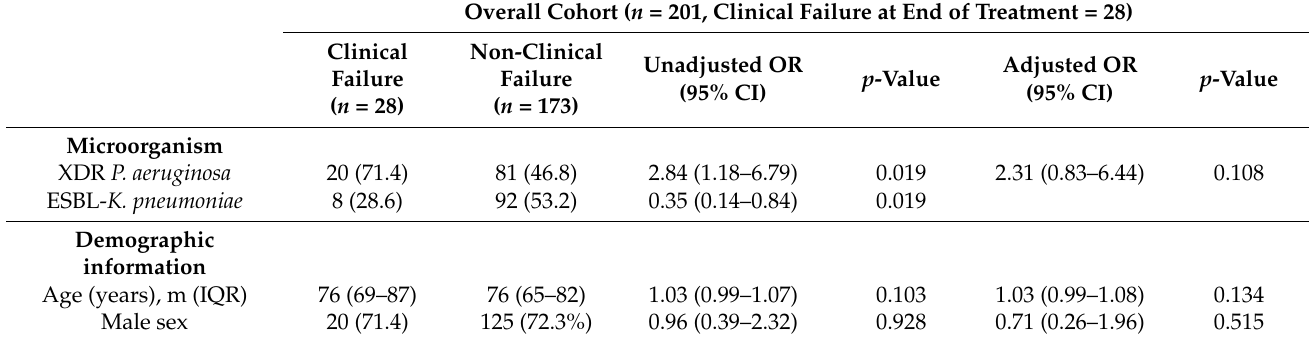
Table 3. Univariate and multivariate analysis of parameters predicting clinical failure at end-of